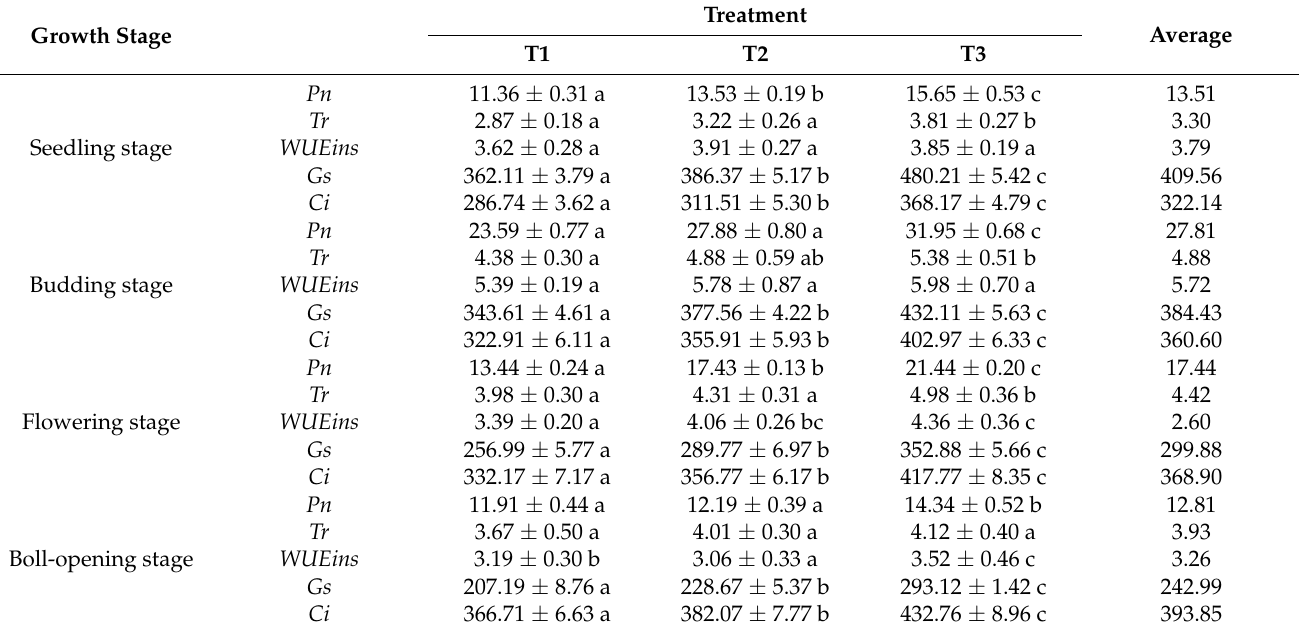
Table 4. Effects of different irrigation methods on net photosynthetic rate ( Pn) , transpiration rate ( Tr ), intercellular CO 2 concentration ( Ci ), stomatal conductance ( Gs ), and WUEins .